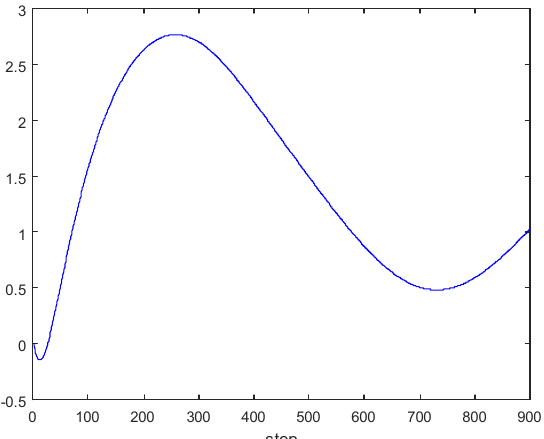
Figure 7. Step response of the 9th order model after reduction to common denominator simulated for 900 time-steps.